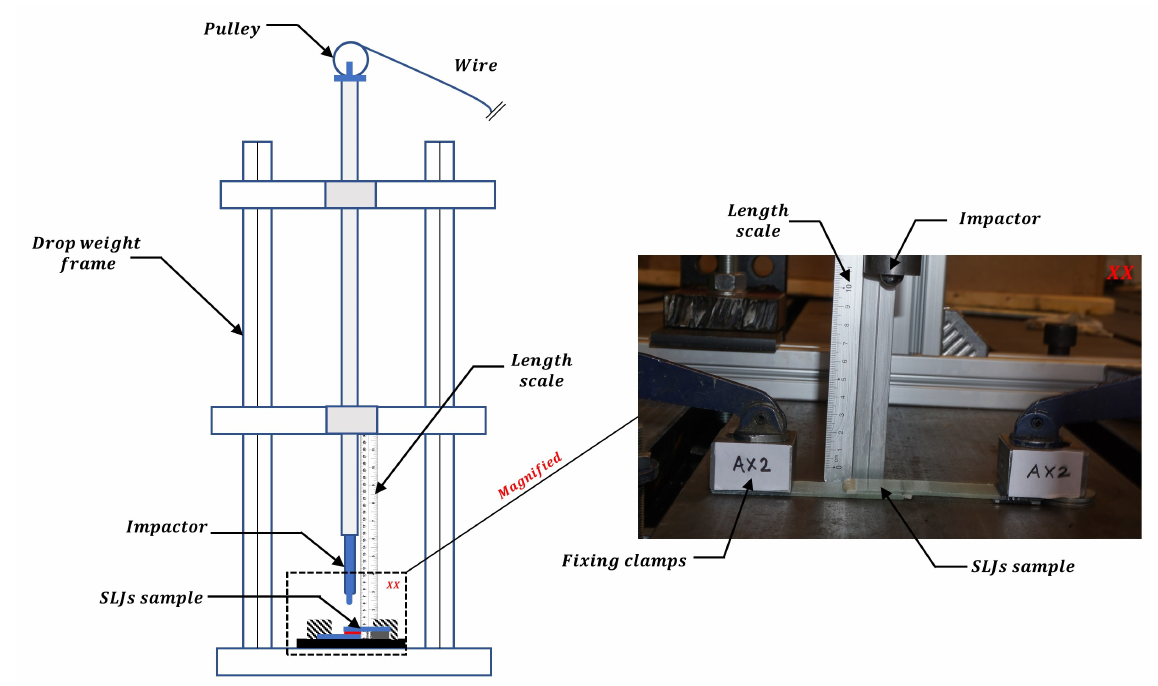
Figure 9. Test setup constructed for impact testing on single lap adhesive